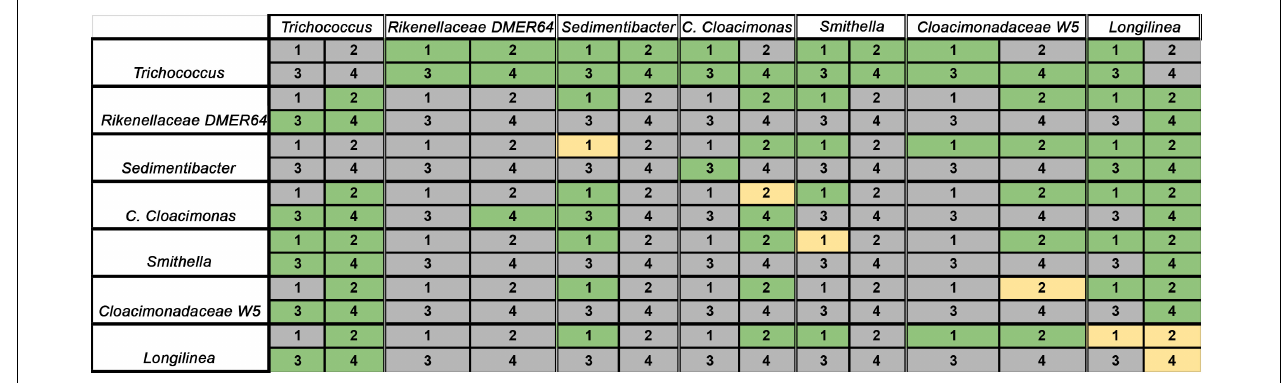
FIGURE 7 | Ecological interactions among the most abundant bacteria in all samples, as deduced from generalized Lotka–Volterra model. Gray: negative interaction; Green: positive interaction; Yellow: no interaction. The numbers 1 – 4 indicate the reactors with the respective stressors: 1: control; 2: perturbation with nalidixic acid; 3: γ -aminobutyric acid (GABA; FG); 4: sodium phosphate